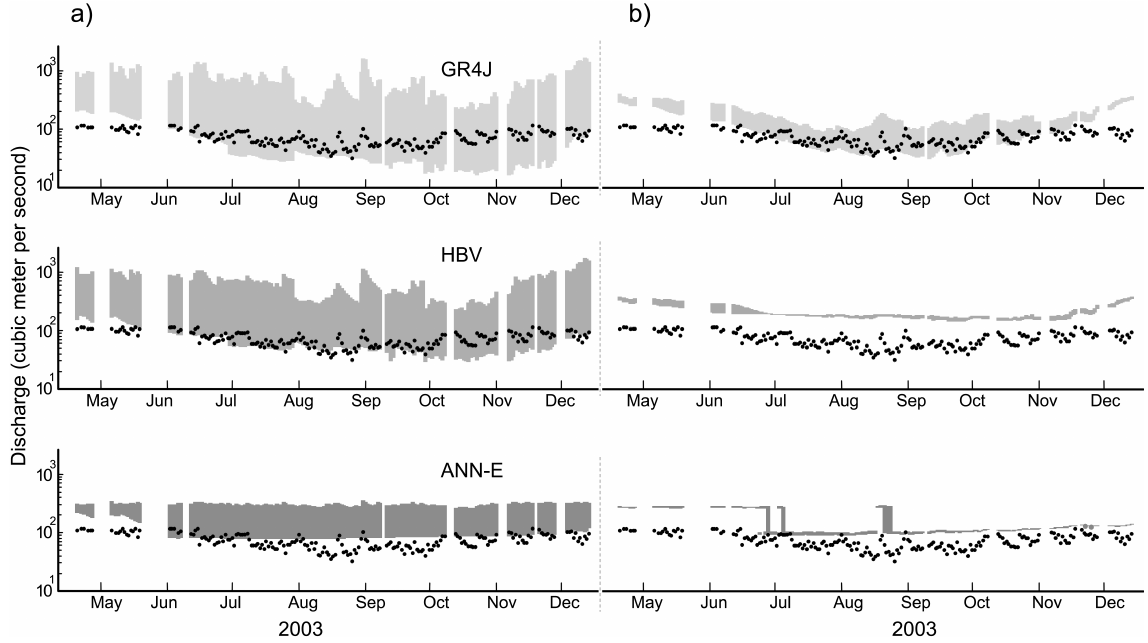
Figure 4. Range (shown as grey shade) of low-flow forecasts in 2003 for a lead time of 90 days using (a) ensemble P and climate mean PET (case 2) and (b) climate mean P and ensemble PET as input for GR4J, HBV and ANN-E models (case 3). The gaps in the figures indicate non-low-flow days (i.e.